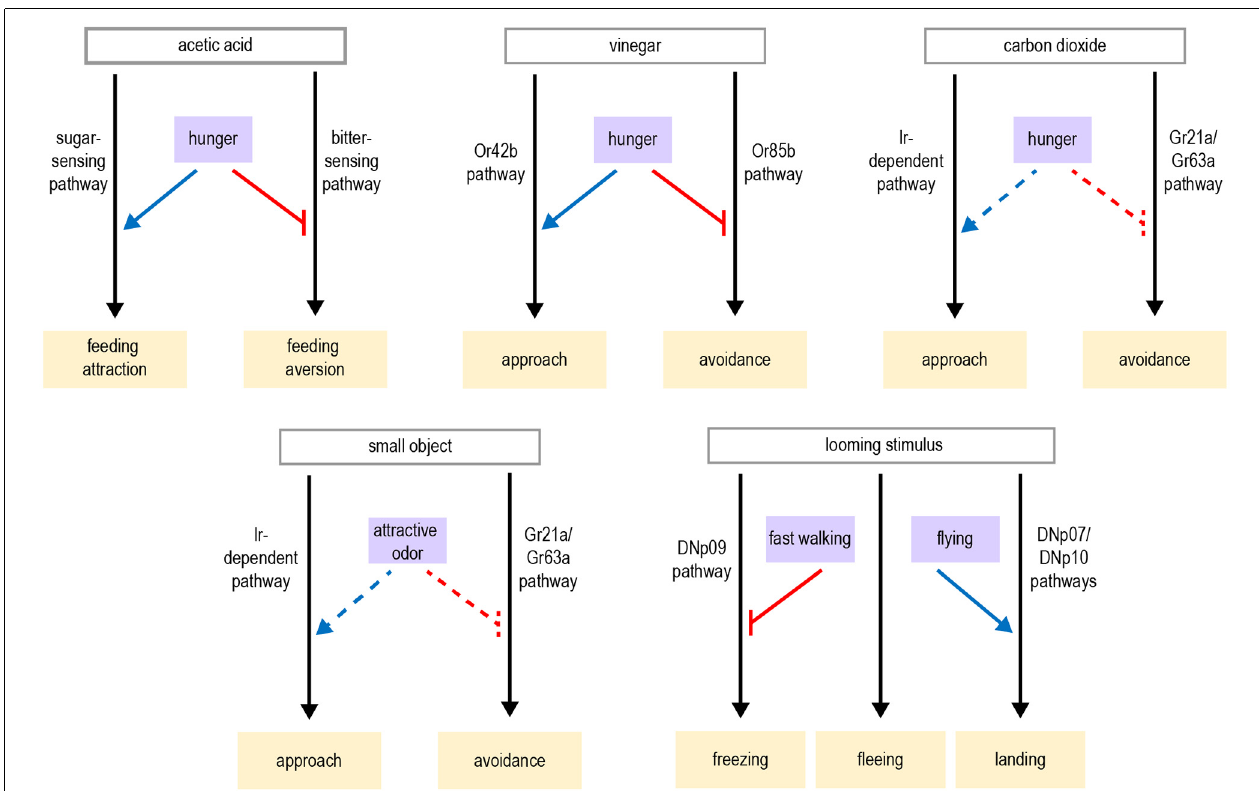
FIGURE 7 | Examples in which the same stimulus can elicit different behavioral responses through competing pathways that are gated by state or context. Black arrows depict neural circuits generating behavior; blue arrows depict excitatory modulation whereas red arrows depict inhibitory modulation. Dashed lines indicate putative types of modulation that have not been experimentally confirmed. For example, it is not known whether fast walking switches the behavioral response to carbon dioxide by enhancing the pathway promoting approach or suppressing the pathway for